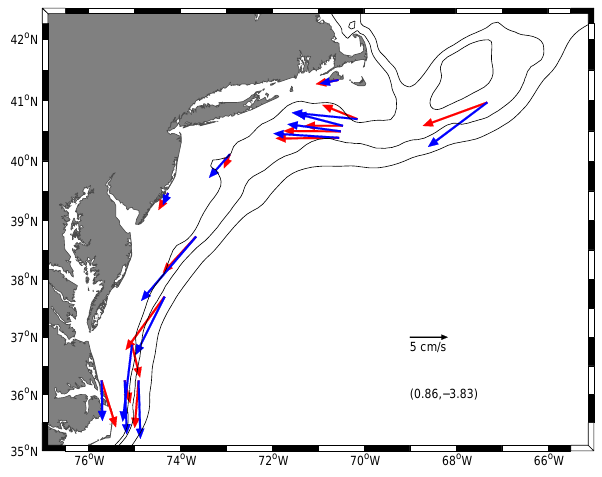
Figure 7. The comparison between observed (red; Lentz, 2008a) and MABGOM simulated (blue) mean along-shelf, depth-averaged currents. Amplitude and angle of complex correlation between the model and observation are shown in the parentheses (amplitude, an-